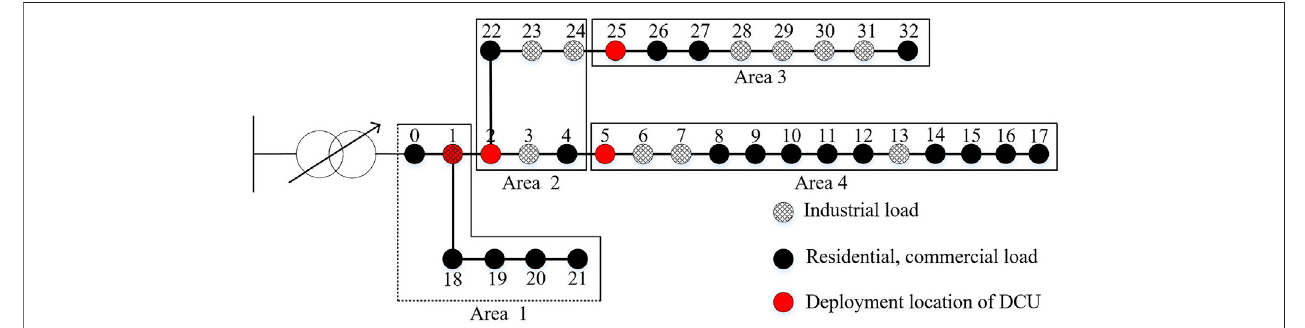
FIGURE 7 | The improved IEEE-33 node distribution system with 4 areas.